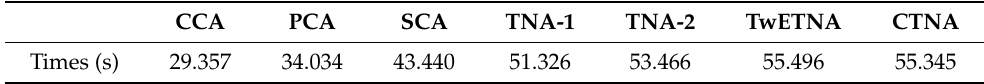
Table 5. Computational time to perform 100 DOA